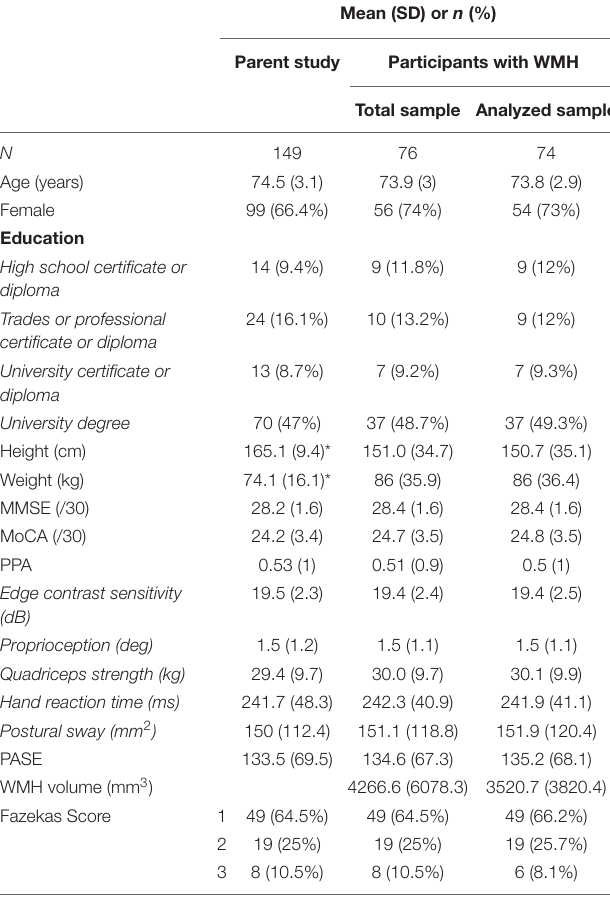
TABLE 1 | Participant